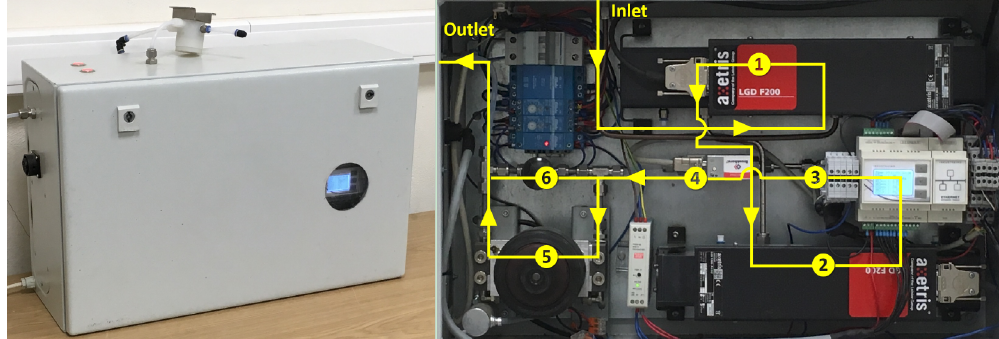
Figure 3. External (left) and internal (right) view of the AMS. The gas flow direction through the system is marked with arrows. The main components are indicated by circled numbers: 1 (cid:13) Axetris LGD F200-A NH 3 , 2 (cid:13) Axetris LGD F200-A CO 2 (not tested in this study), 3 (cid:13) pressure transducer, 4 (cid:13) mass flow meter, 5 (cid:13) vacuum pump, 6 (cid:13) needle